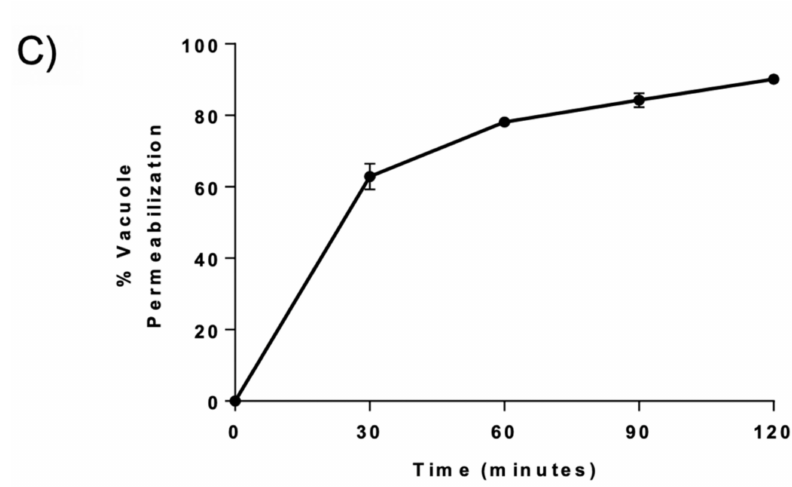
Figure 6. Evaluation of vacuolar membrane permeabilization and Pep4p release. ( A ) Fluorescence microscopy images of BY4741 cells after 30 min of treatment with BaP1 (300 µ M) or DMSO (negative control). ( B ) Fluorescence microscopy images of W303-1A p416 ADH-pep4-EGFP cells after 30 min of treatment with BaP1 (300 µ M) or DMSO (negative control). Cells were stained with CMAC to observe vacuolar permeabilization. Samples were collected at different time points, before (time 0) and after 30, 60, 90, and 120 min of treatment and then visualized by epifluorescence microscopy with a 100 × oil immersion objective. ( C ) Percentage of BaP1-treated cells displaying dispersed blue staining pattern correspondent to vacuole permeabilization. The reported values are means with SD ( n ≥ 2). At least 300 cells were counted for each